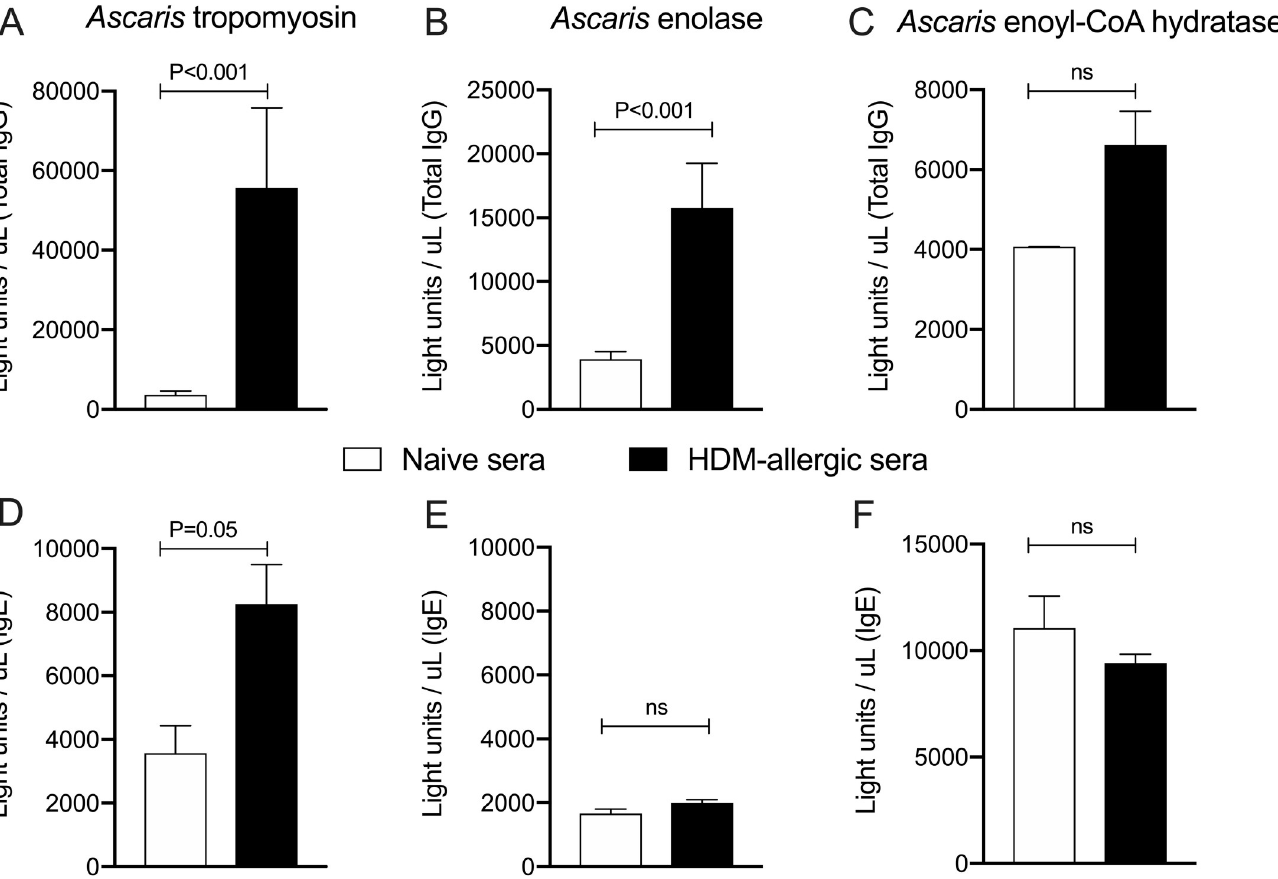
Fig 6. HDM-allergic IgG1 and IgE recognize lung-stage Ascaris recombinant proteins. LIPS assay showing the HDM-driven IgG (A, B, C) and IgE (D, E, F) reactivity to Ascaris -encoded tropomyosin (A-D), enolase (B-E) and enoyl-CoA hydratase (C-F). Data are expressed as light units/uL. Bars represent the Mean + SEM of five pools of sera with 5 mice each from HDM-allergic mice and na ï ve mice. P values are indicated.